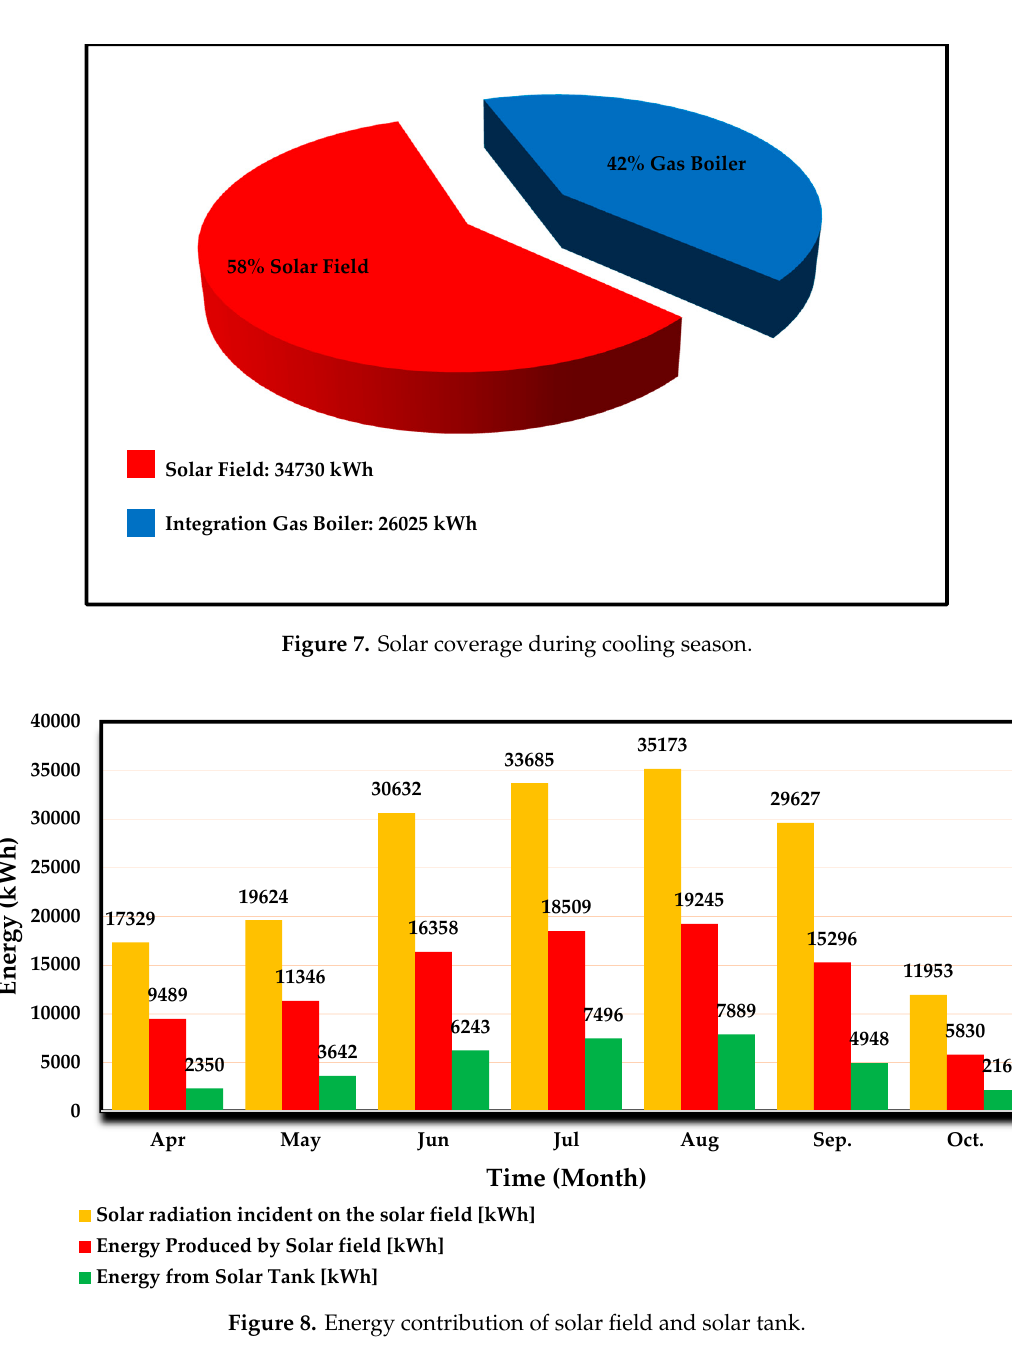
Figure 6. Energy contribution of integration gas boiler and solar field.